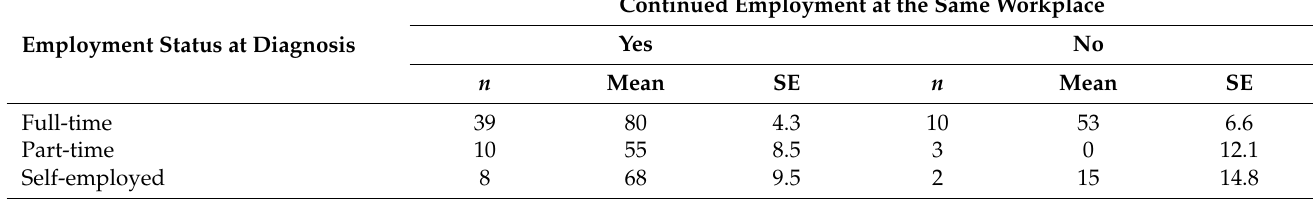
Table 3. Relationship between YIL by employment status and continued employment after diagnosis (pre-diagnosis is set at